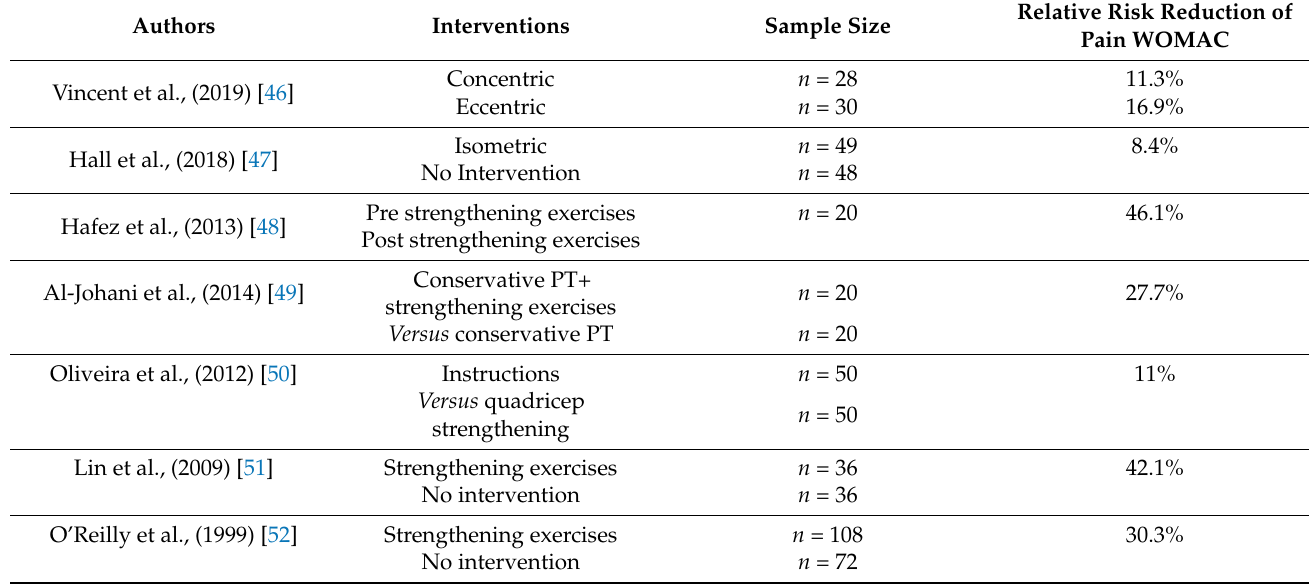
Table 2. Summary of the findings from the seven papers with interventions regarding exercise therapy, sample size, and the relative risk reduction for WOMAC pain